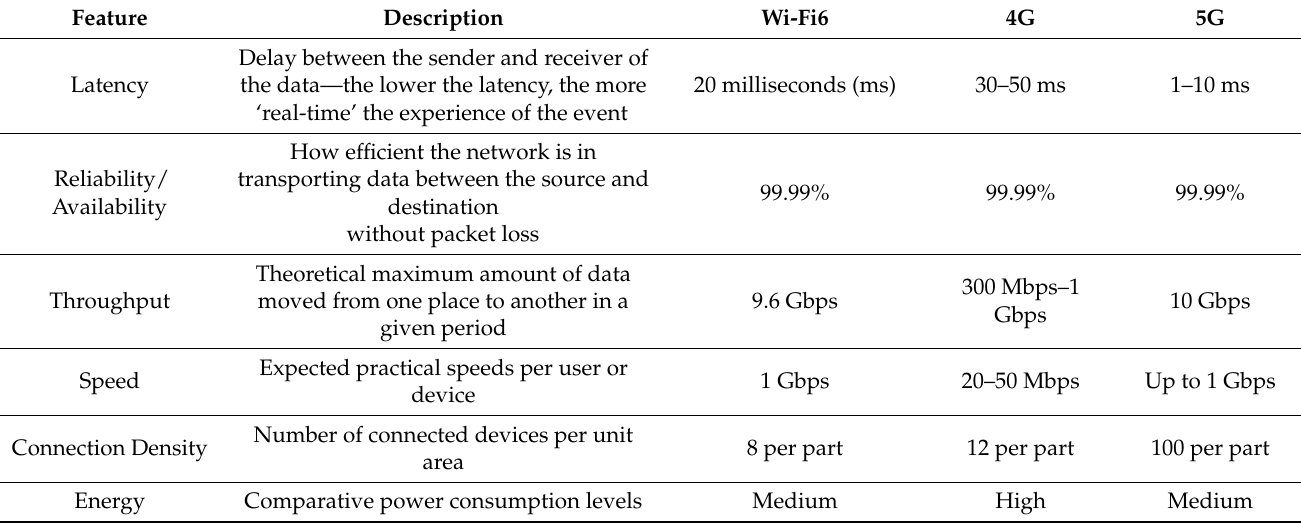
Table 6. Real-time high-capacity, low latency 5G applications (adapted from